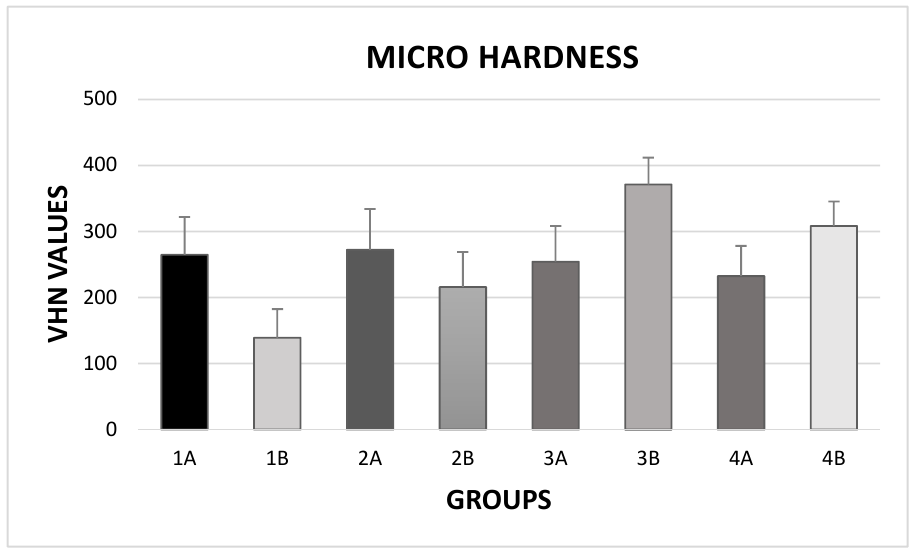
Figure 1. Micro hardness values (Mean and SD) of the different groups.